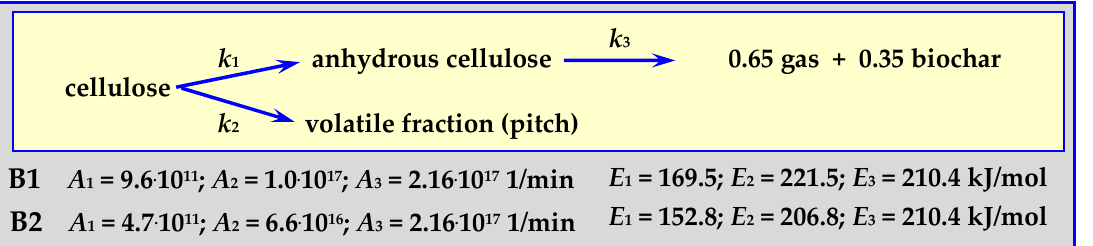
Figure 7. Broido mechanism for cellulose pyrolysis.